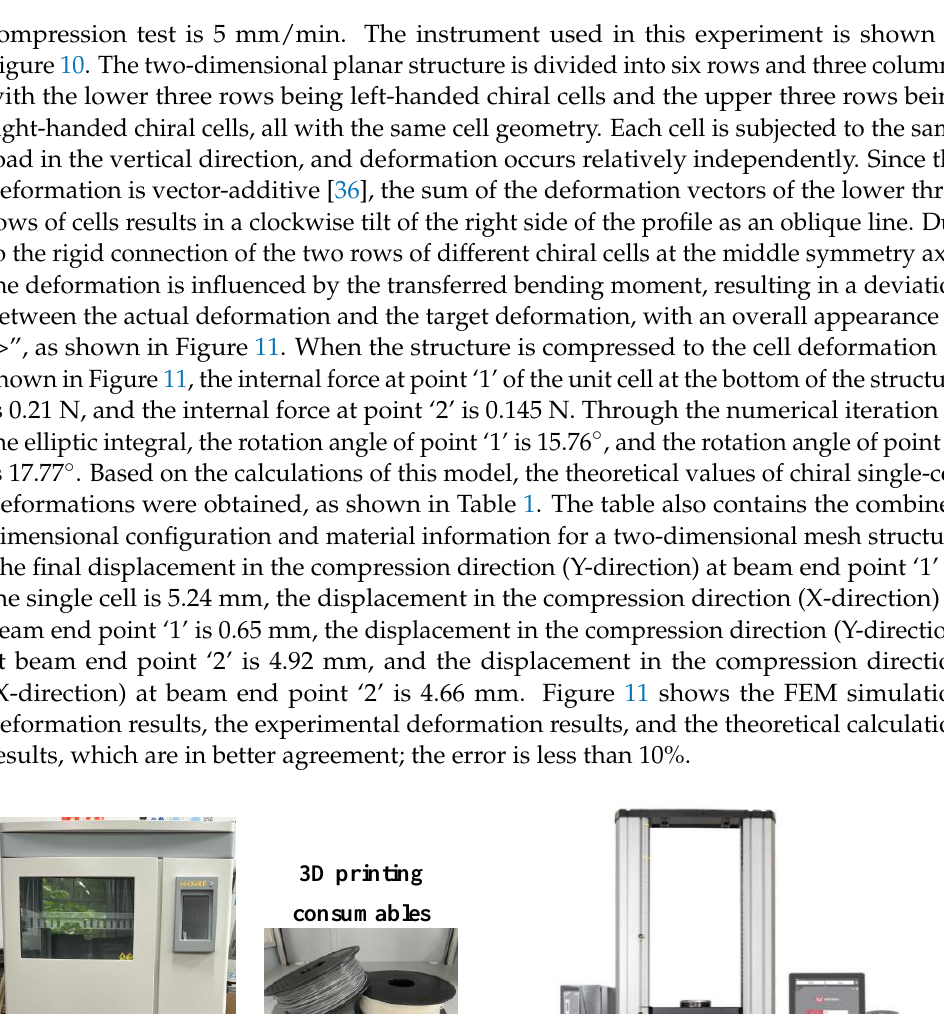
Figure 11. Two-dimensional planar compression – shear coupling deformation of chiral cells. (The red dotted line is the compression-shear deformation on one side of the structure.) 0